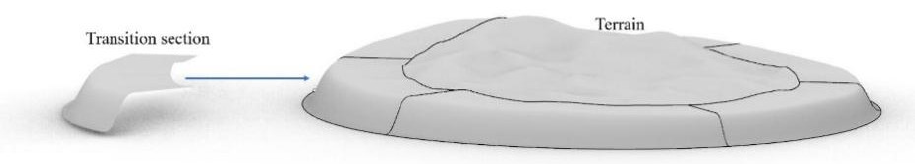
Figure 10. Terrain model and transition section.